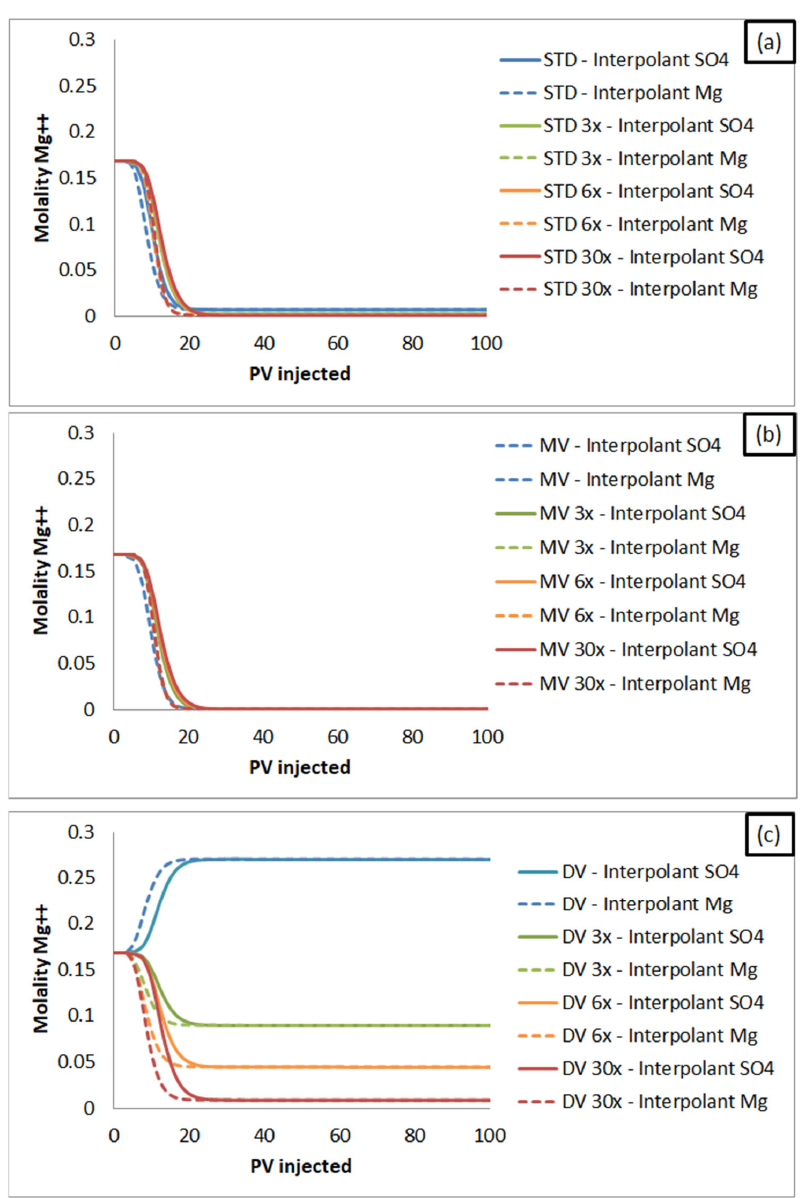
Figure 5. SO 42 − concentration in the effluent for brine injection: ( a ) STD; ( b ) MV and ( c ) DV.